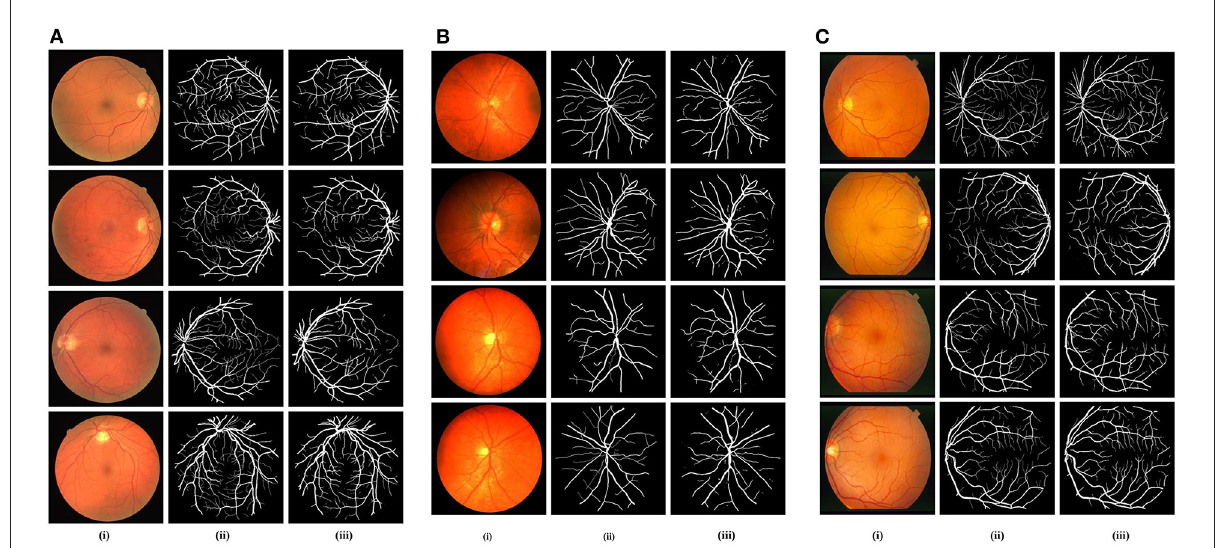
(iii) Predicted mask by FPM-Net. (C) STARE Dataset visualizations of the suggested FPM-Net (i) Input original image, (ii) Expert annotation (Ground truth), and